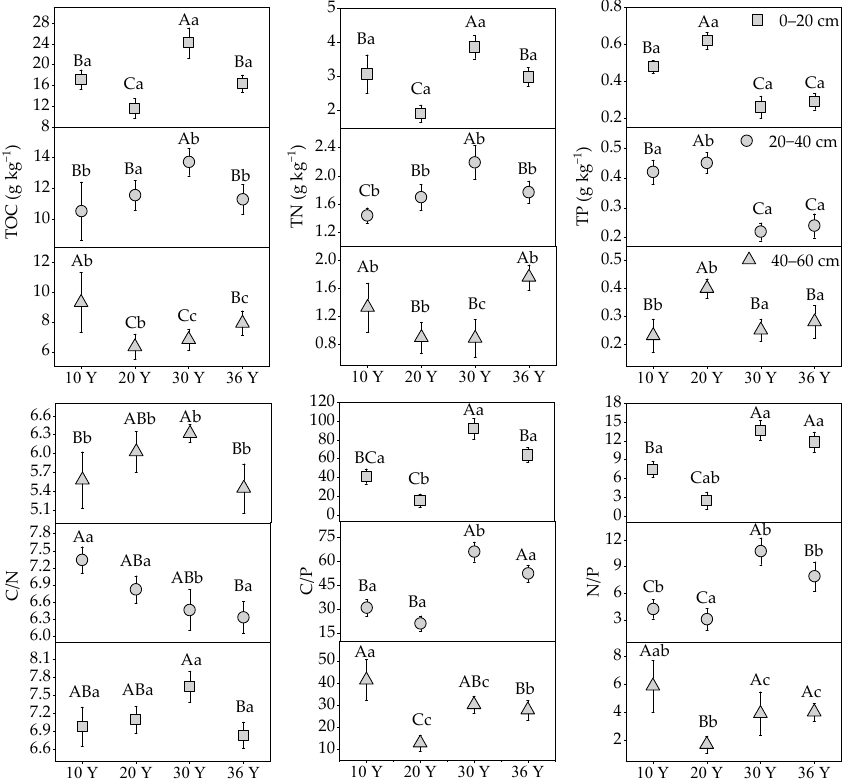
Figure 2. Soil total organic carbon (TOC), total nitrogen (TN), and total phosphorus (TP) concentra- tions and their stoichiometry of different stand ages and soil depths. 10 Y: 10-year stand; 20 Y: 20-year stand; 30 Y: 30-year stand; 36 Y: 36-year stand; 0–20 cm: 0–20 cm soil depth; 20–40 cm: 20–40 cm soil depth; 40–60 cm: 40–60 cm soil depth. The values show means ± SE. Different capital and lowercase letters represent differences among different stand ages and soil depths, respectively ( p < 0.05).